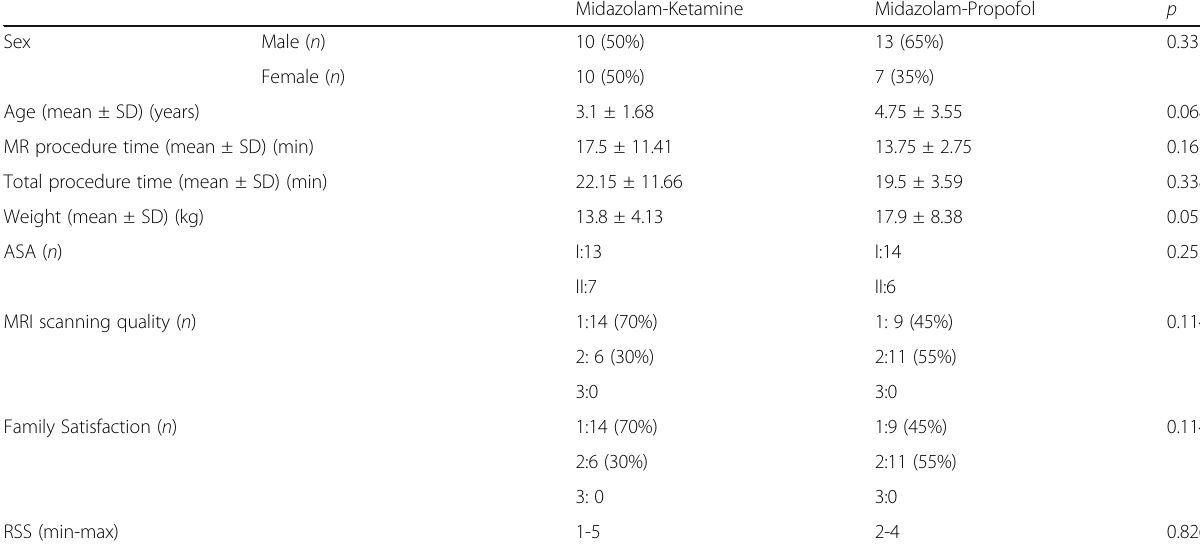
Table 3 Demographic and clinical characteristics